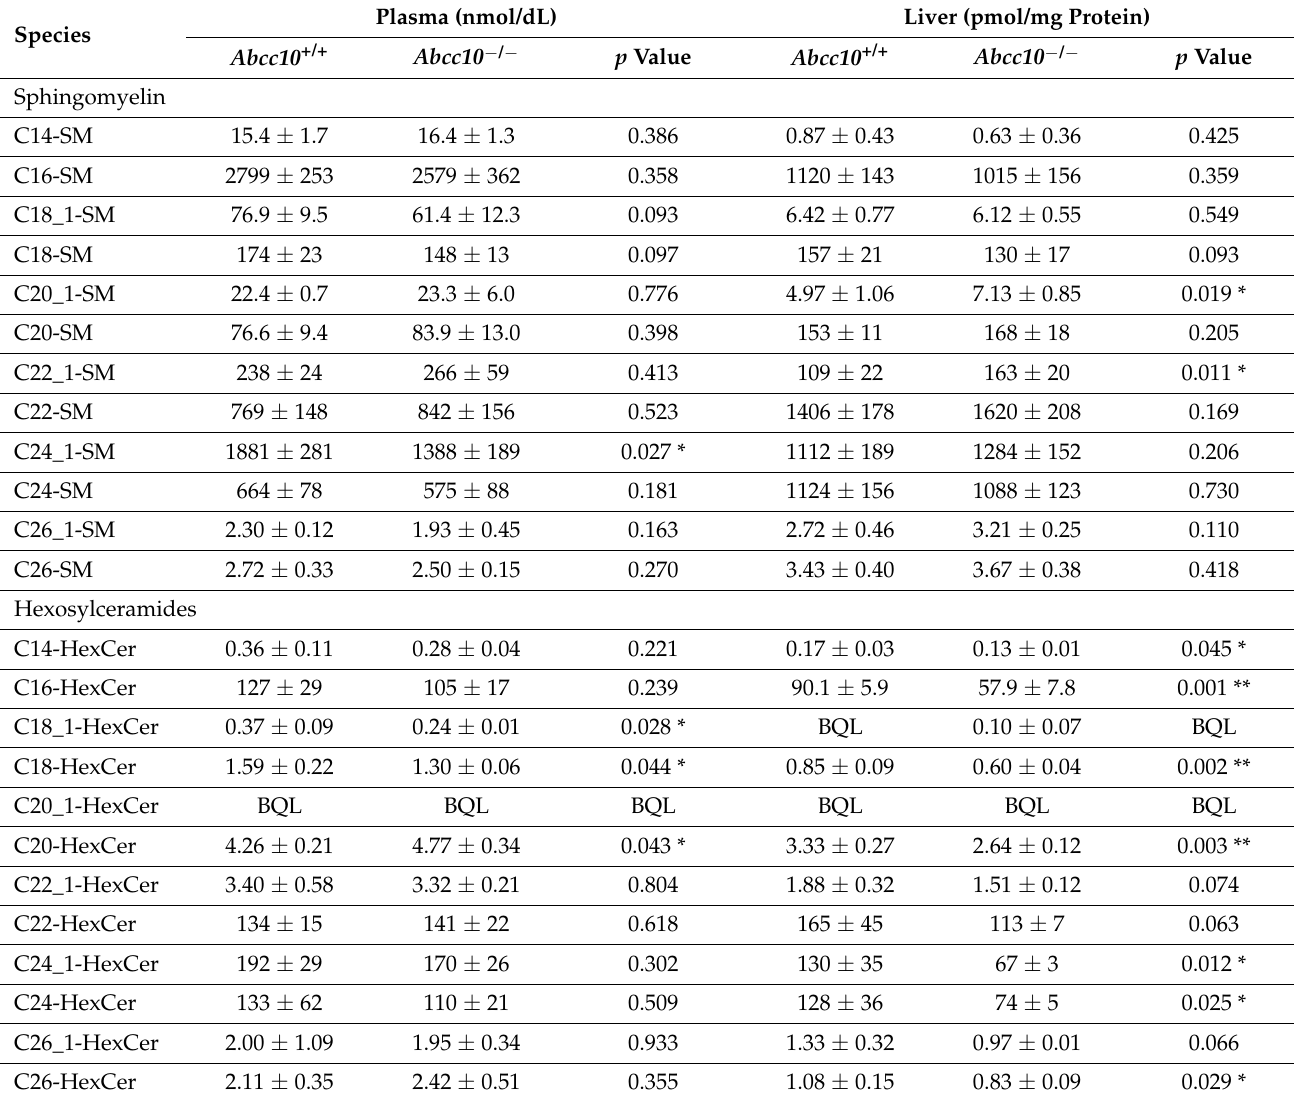
Table 1. Levels of sphingomyelin and hexosylceramide species in the plasma and liver of wild type and ABCC10 knockout